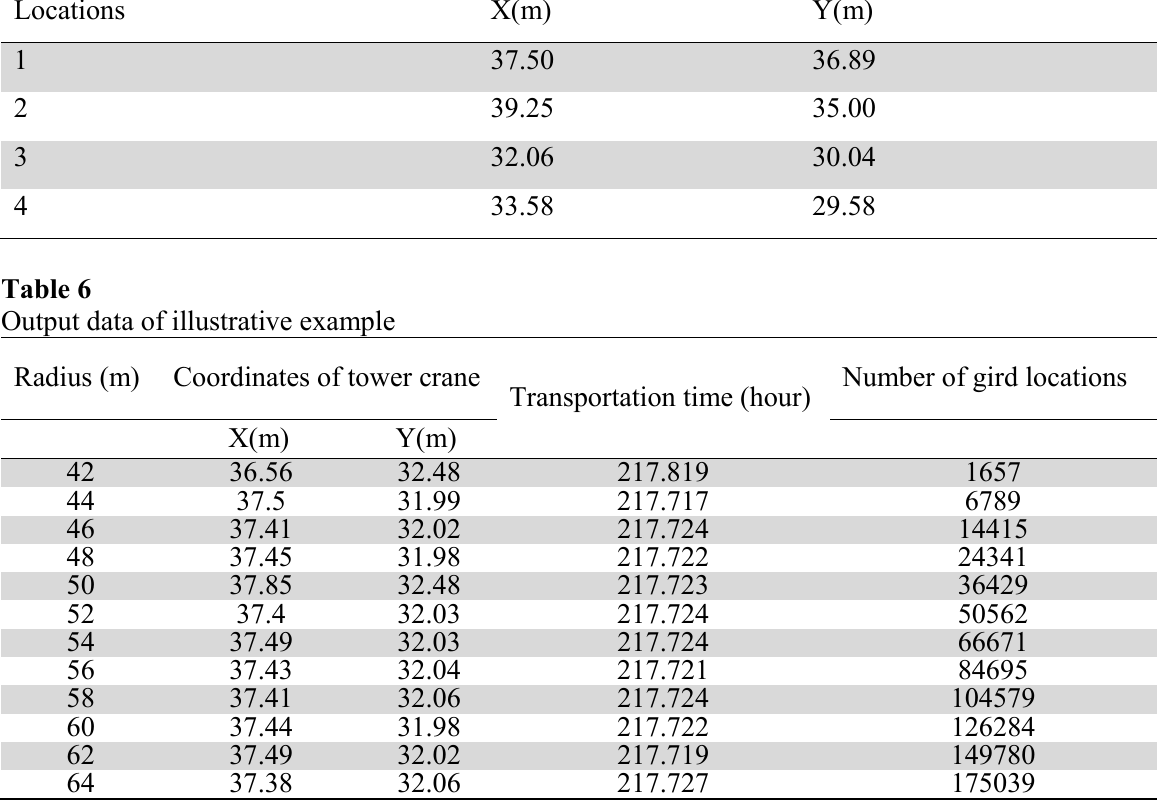
Boundary locations the feasible area for R = 42m Locations